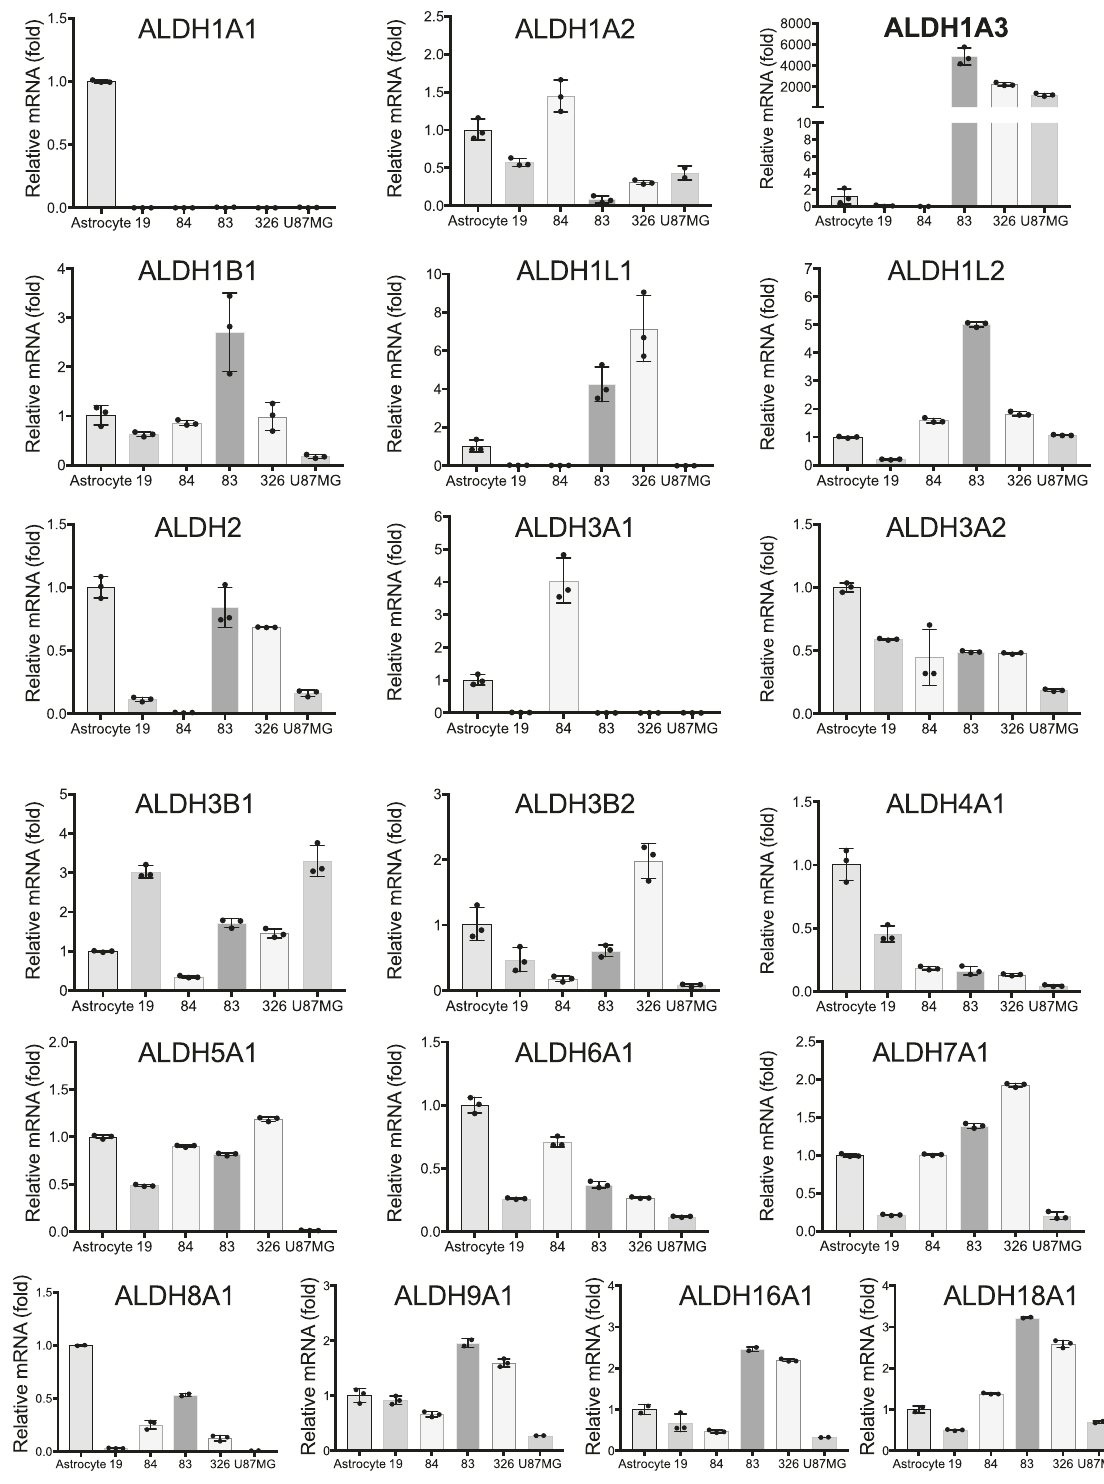
Fig. 1 ALDH1A3 is the dominant ALDH isoform expressed in MES glioma stem cells. Quantitative RT-PCR analysis to measure the mRNA expression level of 19 ALDH isoforms in human astrocytes and GSC-19, GSC-84, GSC-83, GSC-326, and U87MG cells ( n = 3 technical